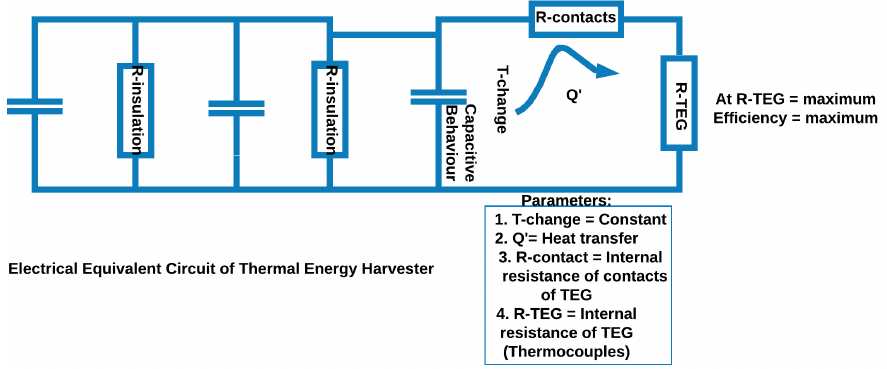
Figure 14. Electrical Equivalent Circuit of Thermal Energy Harvester